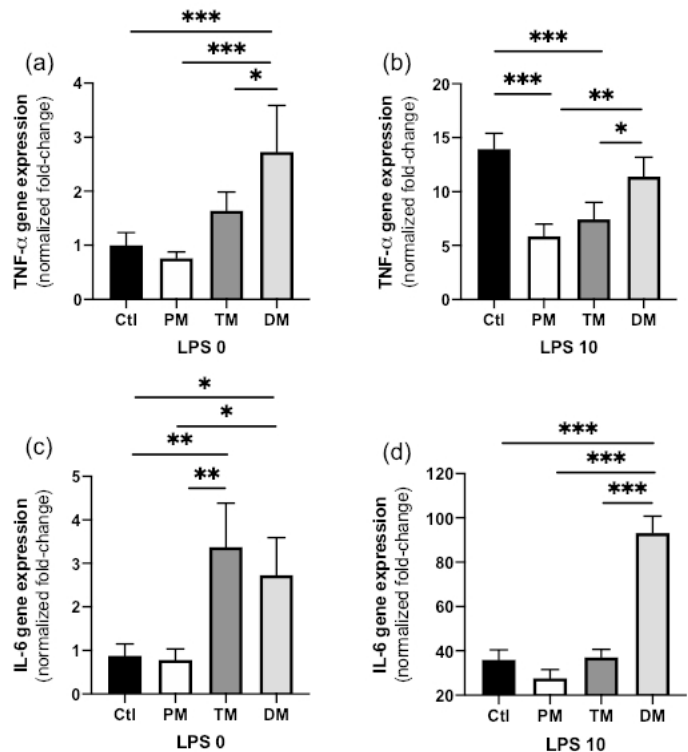
Figure 1. ( a , b ) Tumor necrosis factor (TNF)- α and ( c , d ) interleukin-6 (IL-6) gene expression by human macrophage-like cells derived from the monocytic cell line THP treated with pooled milk from preterm-delivering mothers (PM), term-delivering mothers (TM), pasteurized donor milk (DM) or in absence of milk (Ctl). Macrophage-like cells were incubated with the treatments at 50 μ g total proteins/mL or no treatment (media) for 1 h and then incubated ( a , c ) at steady state (LPS 0 ng/mL) for 3 h or ( b , d ) activated with low-dose lipopolysaccharides (LPS) (10 ng/mL, low inflammatory state) for 3 h. Values are mean ± SD of three independent experiments and three replicates in each experiment. Fold-changes for each gene were normalized to GAPDH and are relative to the gene expression in untreated cells (without LPS or milk). Asterisks show statistically significant differences between groups (*** p < 0.001; ** p < 0.01; * p < 0.05) using one-way ANOVA followed by Tukey’s multiple comparisons tests.